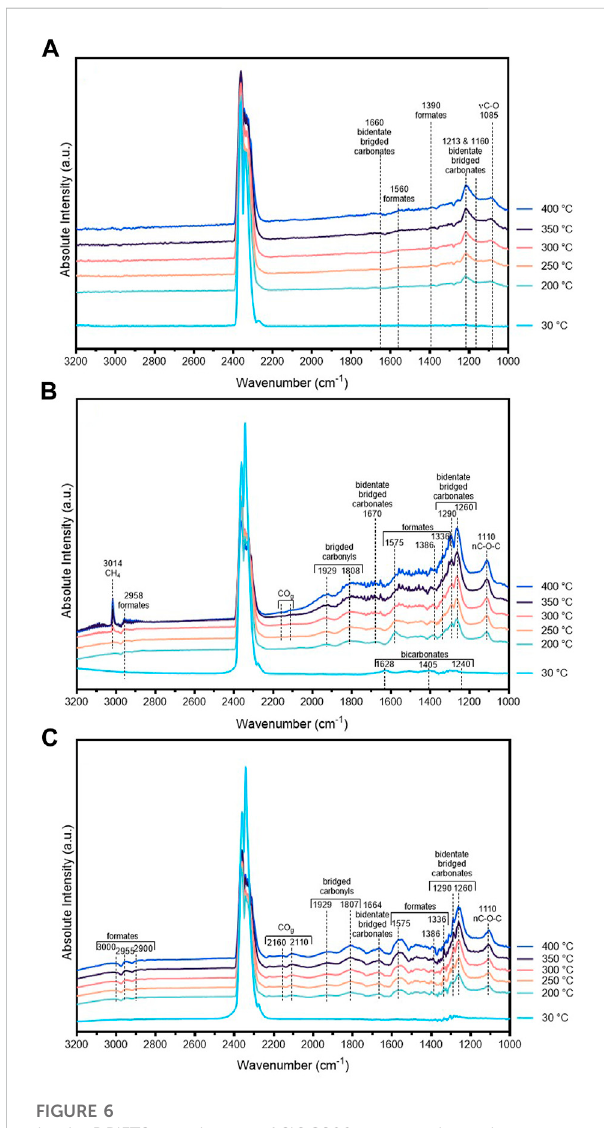
FIGURE 6 In-situ DRIFTS experiments of SiOC800-supported samples under reaction conditions (He/H 2 /CO 2 = 5:4:1) at different temperatures: 5Ni/SiOC800 (A) , 5NiLa/SiOC800 (B) and 5La/ SiOC800 (C) . For each measurement, a background spectrum recorded under He at room temperature was subtracted.